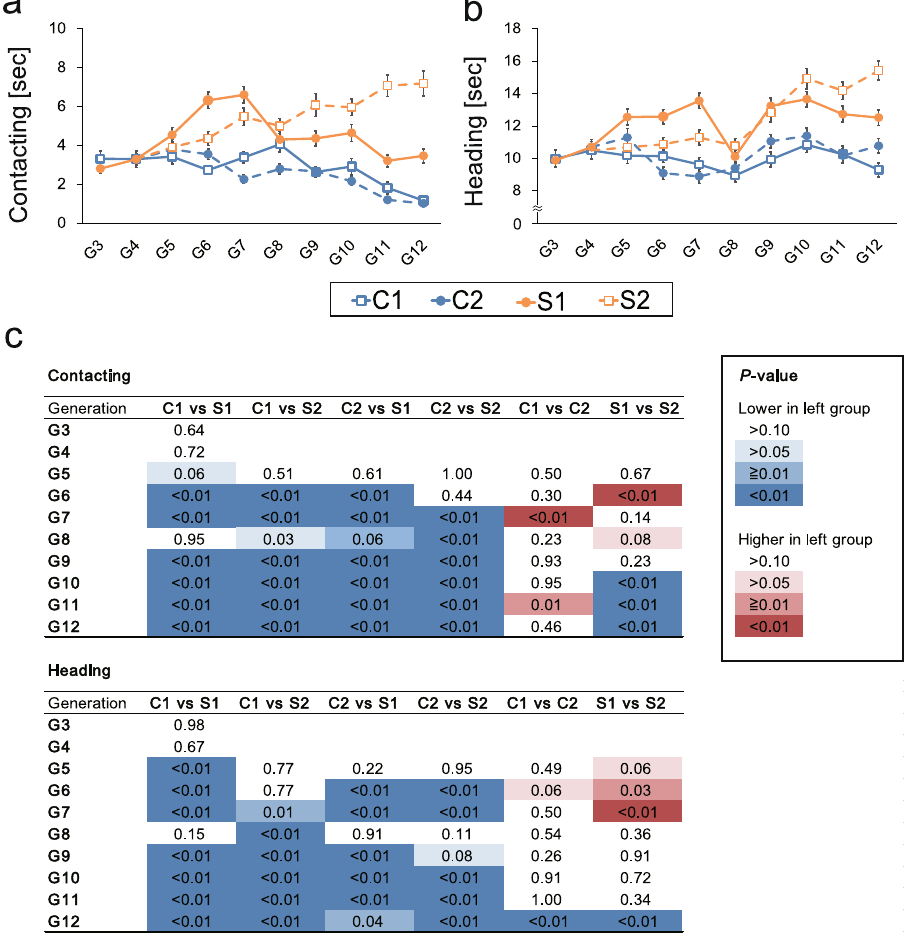
5 Scientific RepoRts | 7: 4607 | DOI:10.1038/s41598-017-04869-1